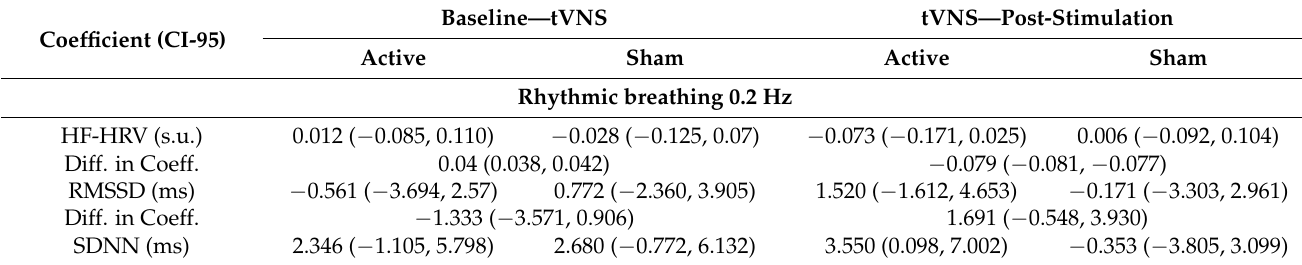
Table 2. Estimated linear mixed model coefficients (Coeff.) with their respective 95% confidence interval (CI-95) representing the effect of change between baseline and tVNS, as well as tVNS and post-stimulation during the rhythmic breathing tasks at 0.2 and 0.1 Hz. In addition, the differences (Diff.) in coefficients (active minus sham) are displayed with their respective CI-95. s.u. = baseline standardized